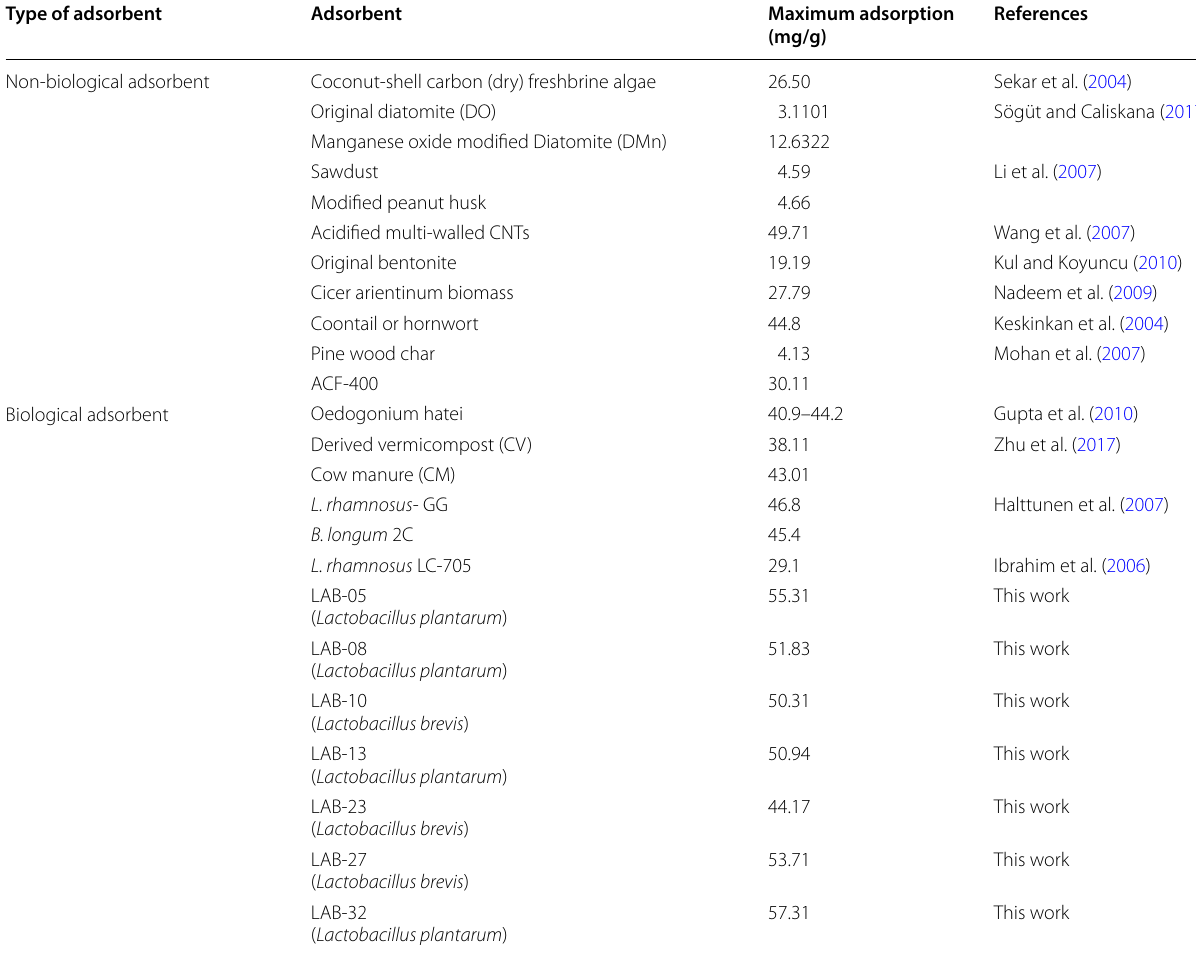
Table 5 The removal rate of different material towards Pb 2 + Type of adsorbent